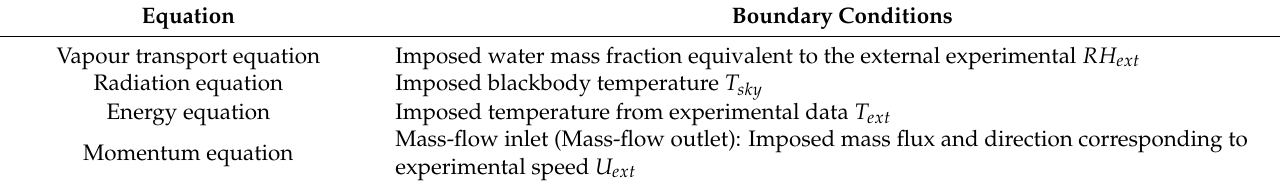
Table A3. Domain inlet/(Domain outlet).